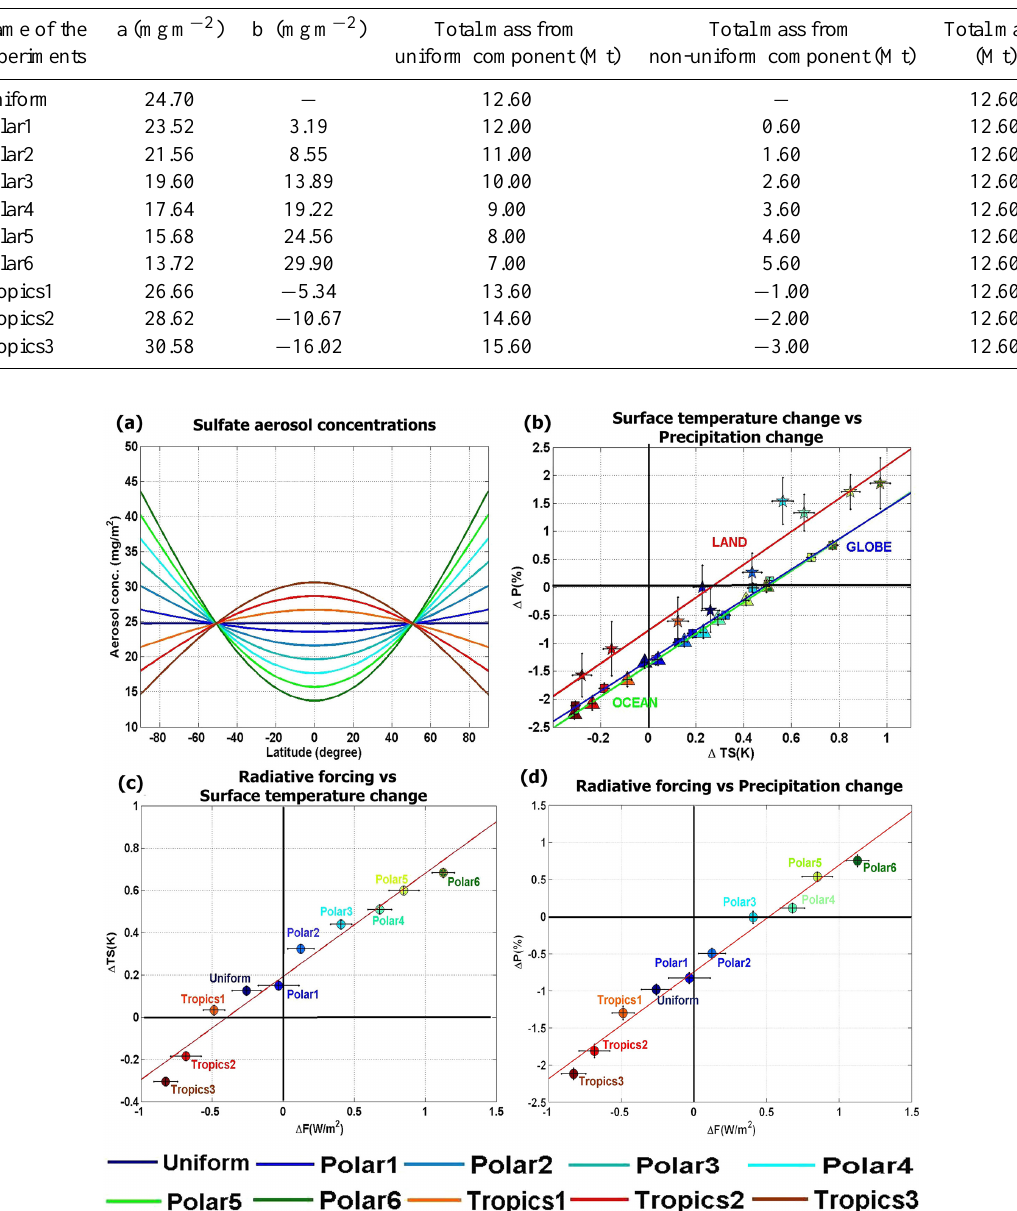
Figure 1. (a) Latitudinal profiles of sulfate aerosol concentration in the SRM geoengineering experiments. Polar1–6 have maximum concen- tration over the poles and Tropics1–3 have maximum at the equator. (b) Surface temperature change (K) vs precipitation change (%) relative to the 1 × CO 2 case from slab ocean simulations (global mean values – squares, land mean values – stars, ocean mean values – triangles). There is warming in all Polar cases relative to the Uniform case and a concomitant increase in precipitation. Opposite is the case for Tropics cases. None of the regression lines pass through origin; temperature and precipitation cannot be offset simultaneously. In the case of land and ocean, 1 TS and 1 P represent the averages over the respective domain. (c) Radiative forcing (RF) vs surface temperature change. Polar cases have larger forcing relative to the Uniform case and hence are warmer while opposite is true for Tropics cases. (d) Radiative forcing vs% precipitation change. Precipitation increases with residual RF (i.e. with increase in polar weighting) while decreases with increase in tropical weighting. In (b) , (c) and (d) , the horizontal and vertical bars represent the standard error of the respective variables which are calculated from the last 30 years of 60-year SOM simulations, while in the case of radiative forcing it is calculated from the last 20 years of 30-year fixed-SST